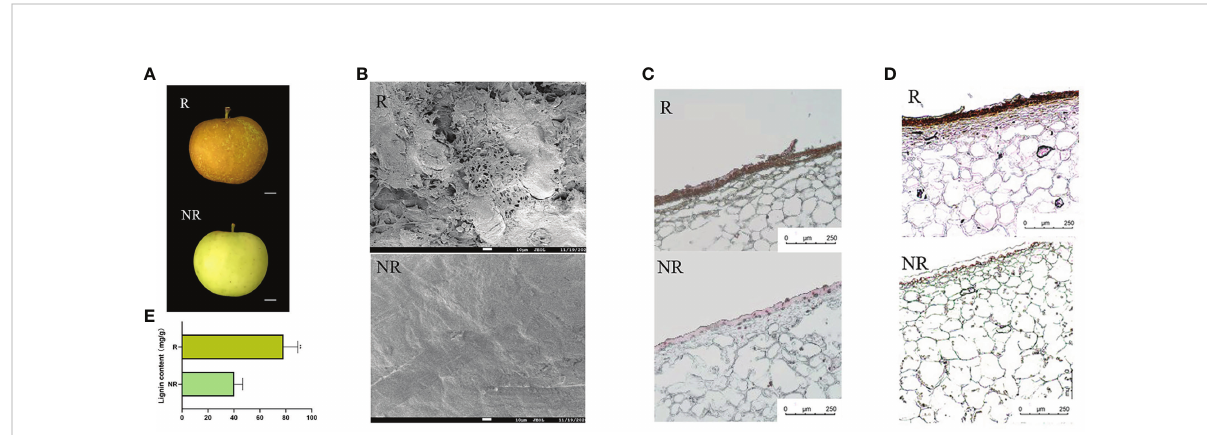
FIGURE 1 The different phenotypes between russet and non-russet apples at 120 DAFB. (A) Fruit phenotypes of the two apples. (B) SEM images of russet and non-russet apple fruit skins (scale bars: 10 m m). (C) Sudan red 7B staining of russet and non-russet fruit skins (scale bars: 250 m m). (D) Phloroglucinol staining (reddish color) of fruit skins (scale bars: 250 m m). (E) Lignin content between russet and non-russet fruits. Signi fi cance was calculated according to Student ’ s t-test : ** P <